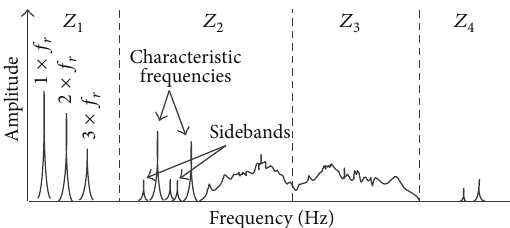
Figure 1: Main frequency zones in mechanical